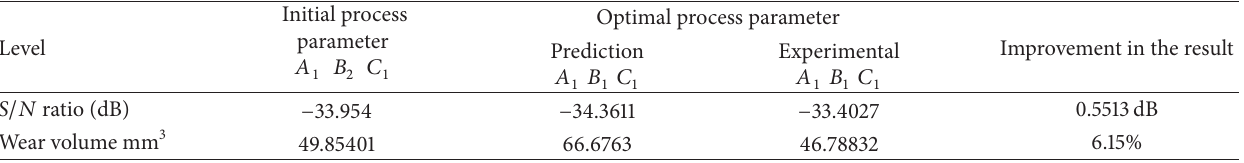
Table 10: Confirmation test for wear